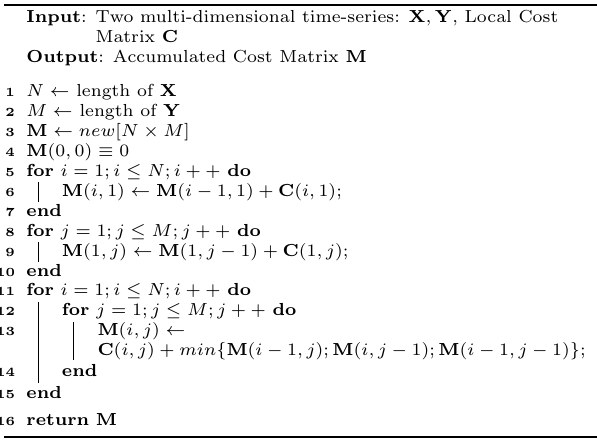
Figure 7: Intuition of p ABOD Algorithm 1: Accumulated Cost Matrix